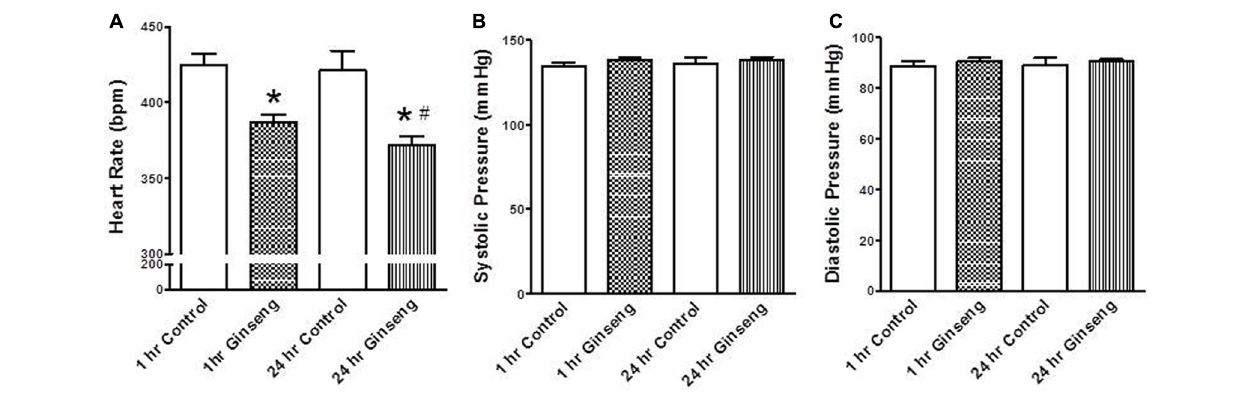
FIGURE 2 | Non-invasive measures of blood pressure recorded from control animals and those treated with water-soluble ginseng extract ( n = 8/group; 1 and 24 h after gavaging). (A) Shows the HR responses.